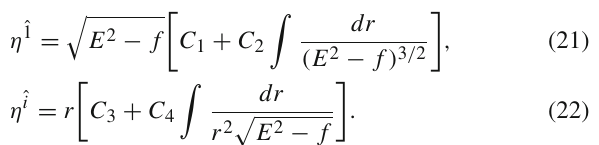
Fig. 2 The change of R stop , R rtf constant α . Here we set M = 1 and b =